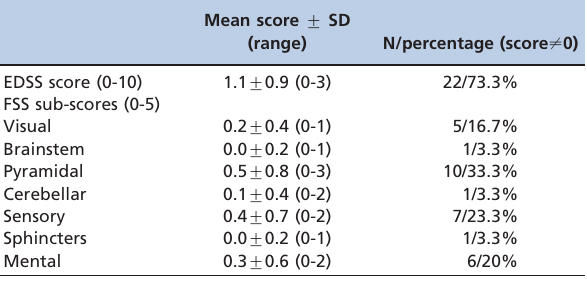
Table 1 - Disability scores in relapsing-remitting multiple sclerosis